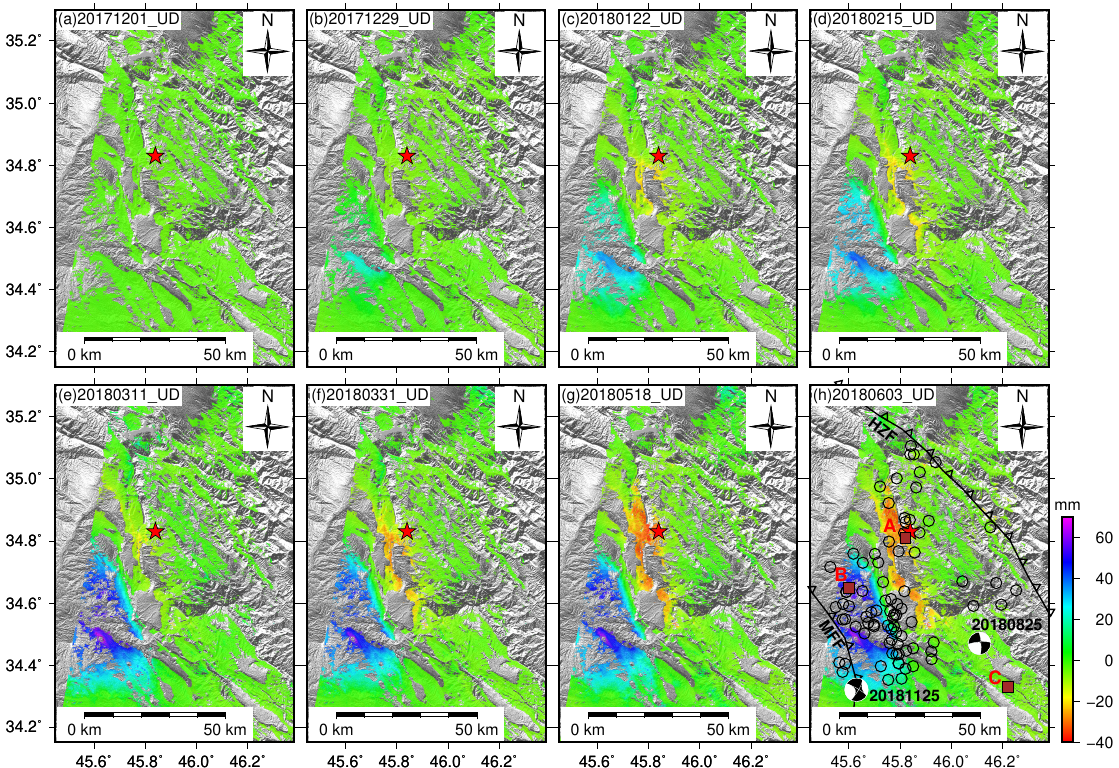
Figure 9. Time series of the cumulative up-down (UD) deformation from 19 November 2017 to 3 June 2018 (positive and negative values represent uplift and subsidence, respectively). The black circles indicate aftershocks (M W > 3.0) up to 220 days after the mainshock. The brown squares represent the selected feature patch. The two beach balls represent earthquakes > M W 5.0. Red stars represent the